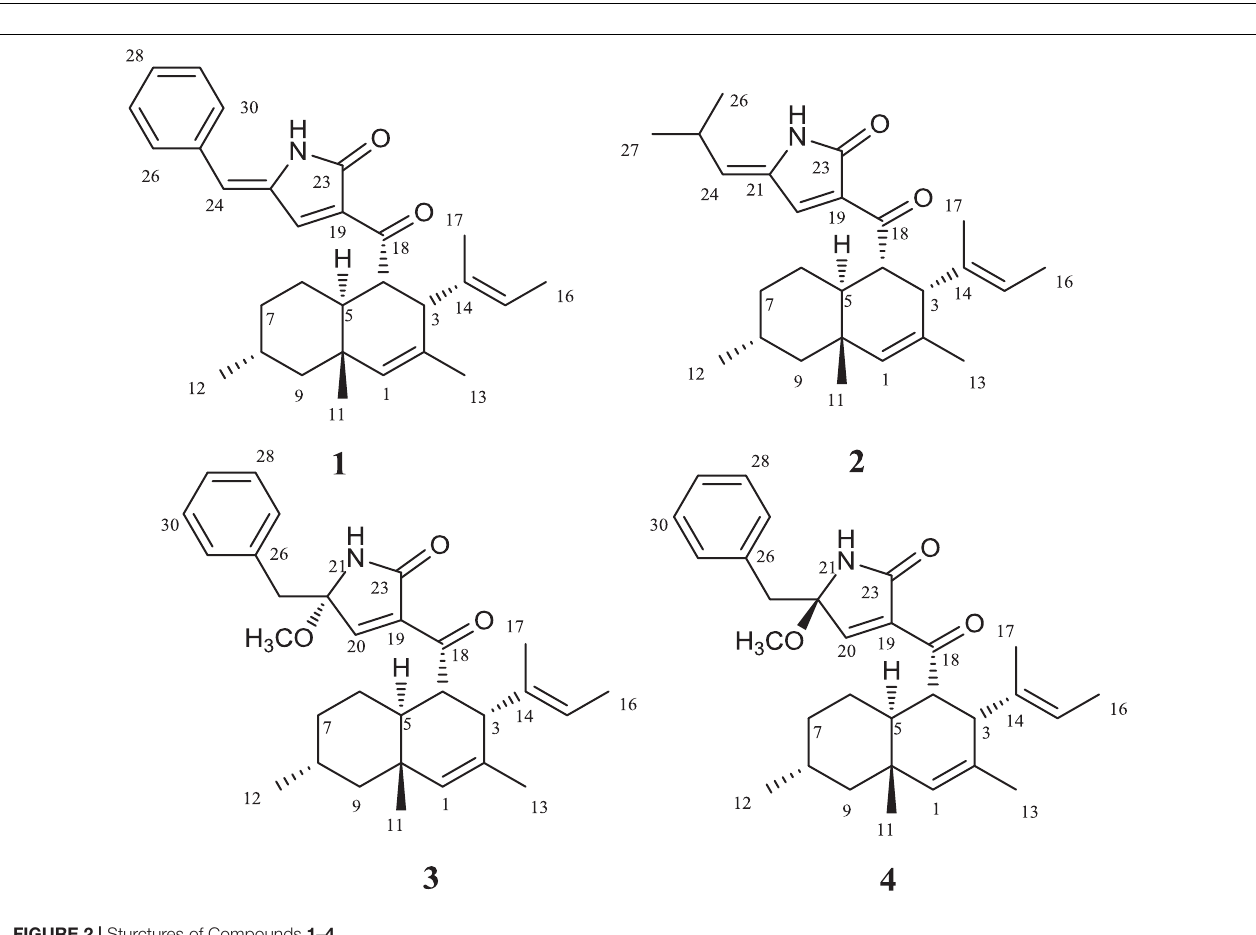
FIGURE 1 | Comparison of Cha cluster and homologous gene cluster myc containing a PKS-NRPS hybrid, a DAse and a trans -ER. PKS-NRPS, polyketide synthase–non-ribosomal peptide synthetase; ER, enoylreductase; DAse, Diels–Alderases; MFS, major facilitator superfamily; α / β hydrotase, Alpha/beta hydrolase family.